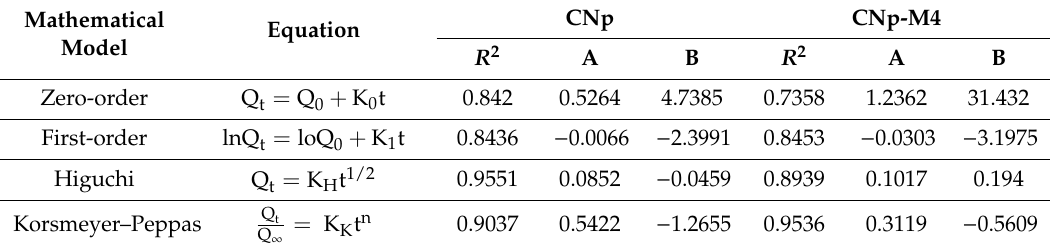
Table 3. Squared of the correlation coefficient (R 2 ) and coefficients obtained after the linear regression of release data from CNp and CNP ‒ M4 utilizing four mathematical models.